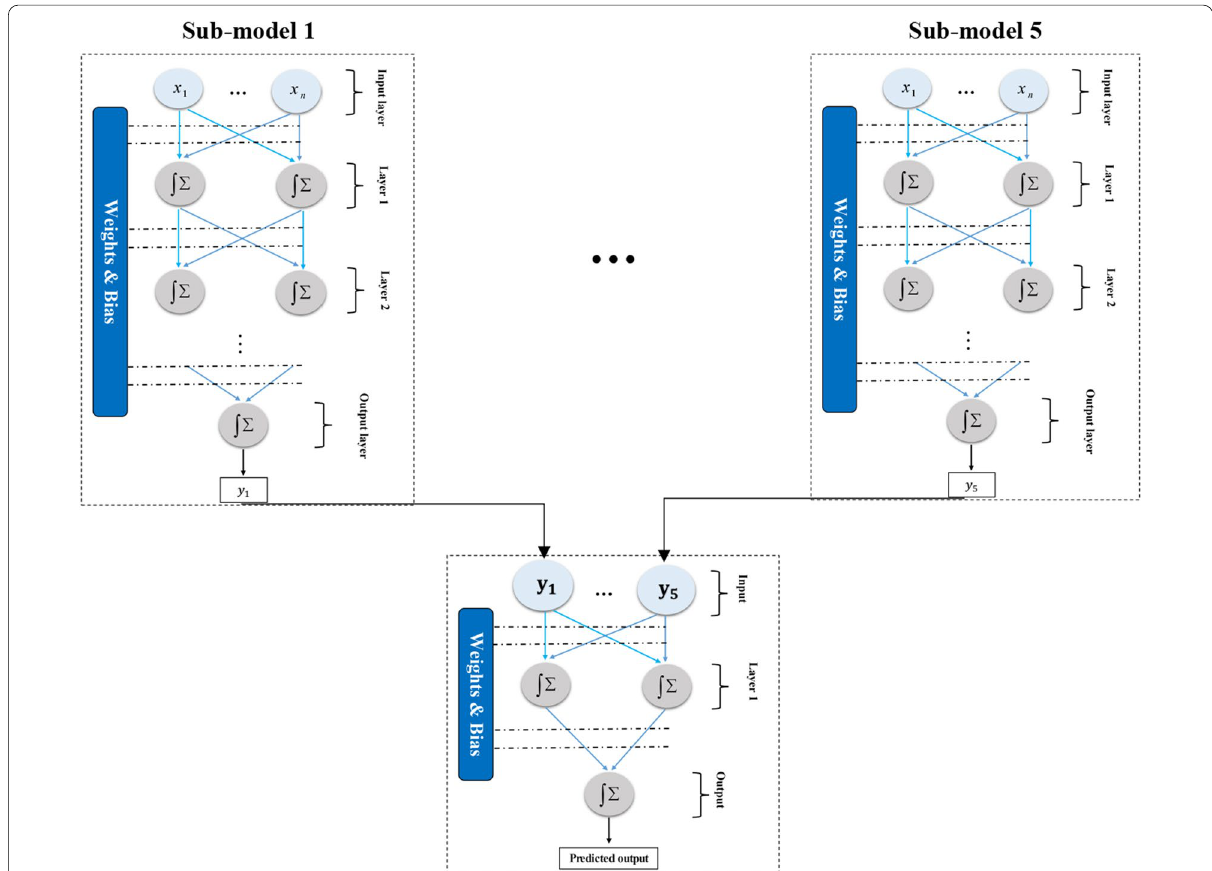
Fig. 7 Flowchart of the ISE method.